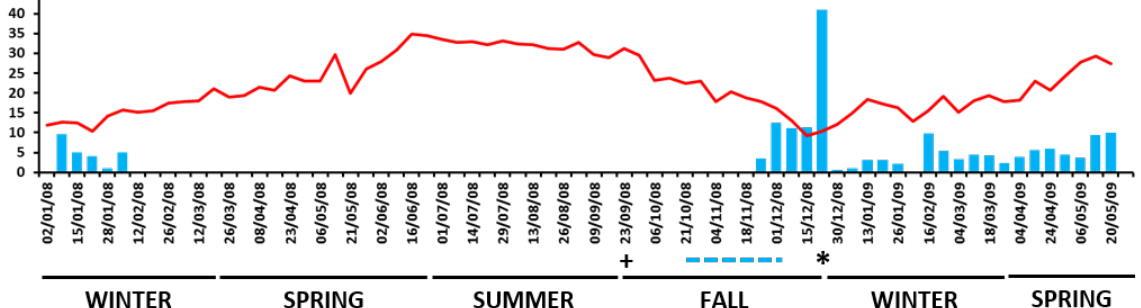
Figure 2. Total numbers of Eutypella spores trapped per week using glass microscope slides in the cv. Mid-Night Beauty® vineyard, average temperature and accumulated rainfall per week. Dashed blue line under the x axis shows overhead sprinkler irrigation period at the vine- yard. + indicates week that overhead sprinklers were tested; * indicates pruning